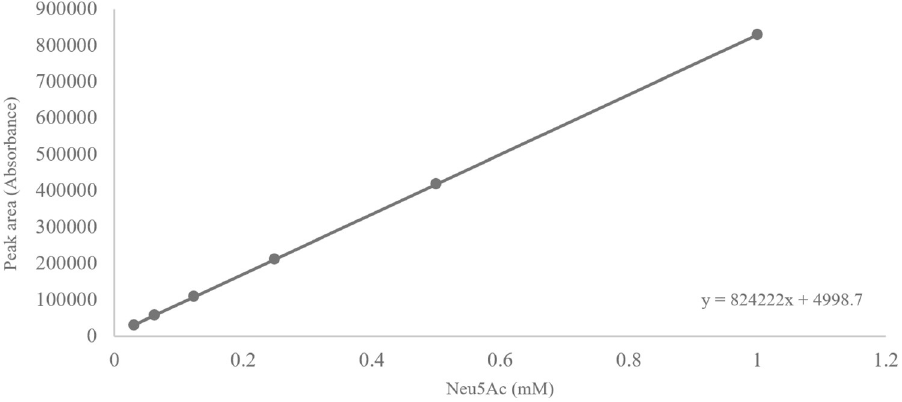
Fig 1. Calibration curve showing the linearity of the method: